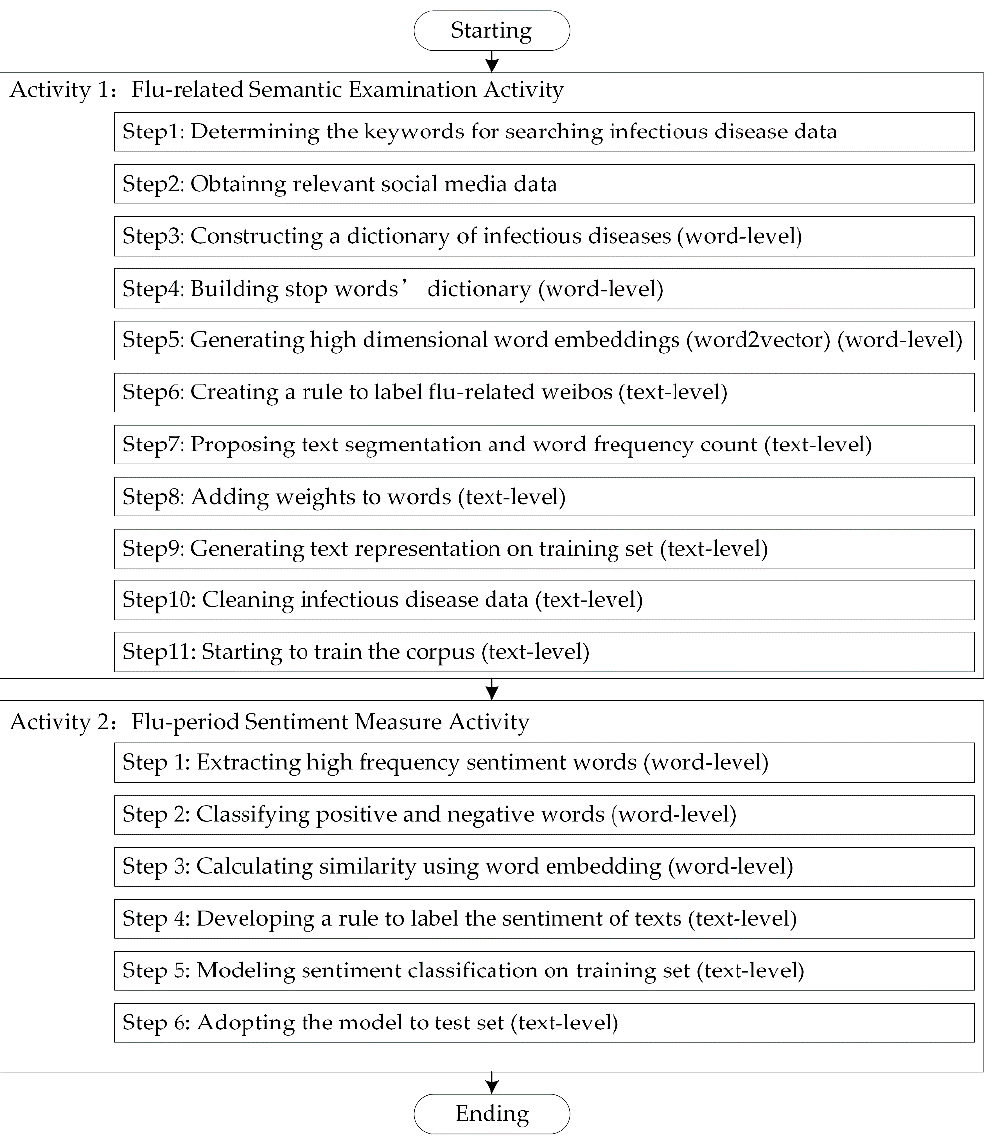
Figure 5. Dual Analytical Activity Model in Channel 3.